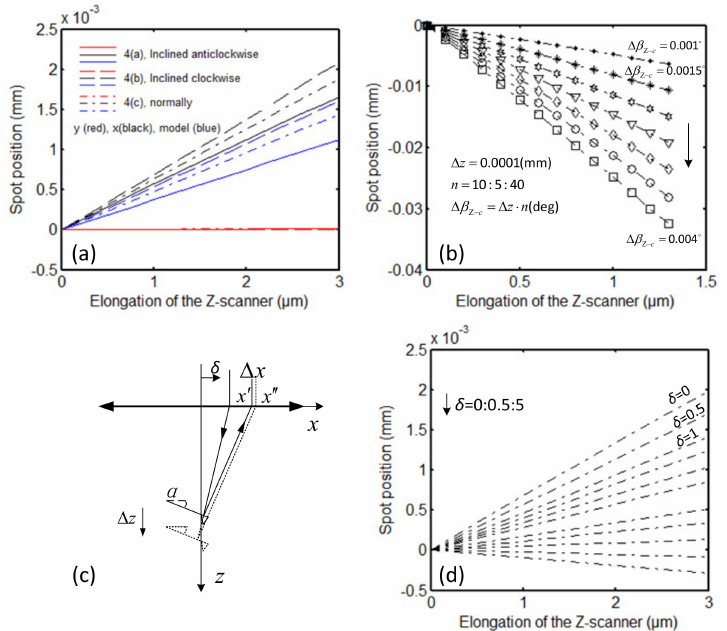
Figure 8. The simulation results of the laser spot movement on the QPD caused by the Z-scanner movement. ( a ) The results for the normal- or oblique-mounted ideal Z-scanner movement, cor- responding to Figure 4a,b. ( b ) The results for the Z-scanner movement in nonideal conditions, corresponding to Figure 4c. ( c , d ) The incident laser enters the aspheric lens with an offset along the x -axis. The blue lines in the figure are the results estimated by the mathematical